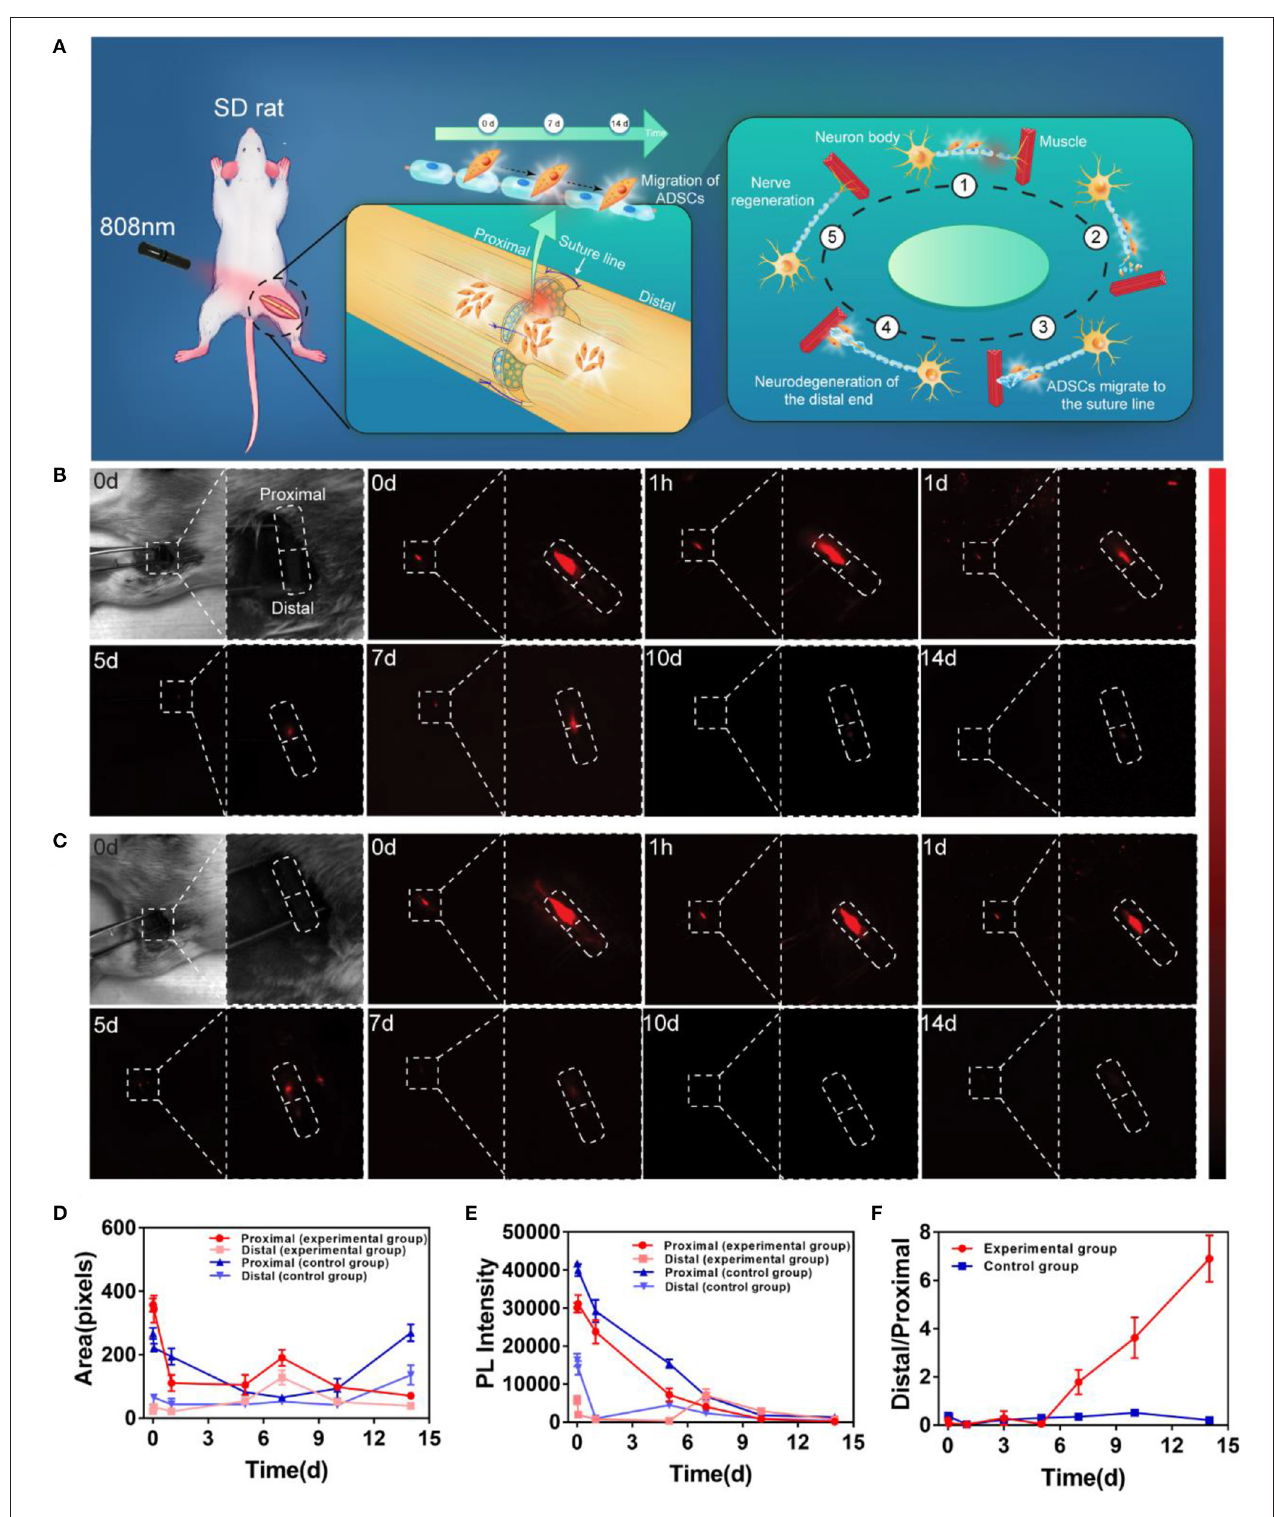
FIGURE 4 | In vivo distribution and migration of PbS QDs labeled ADSCs in a rat model of sciatic nerve injury. (A) Schematic illustration of the in vivo NIR-II imaging strategy. (B) Bright field photograph of the region of interest and NIR-II imaging of the experimental group (injected with PbS QDs labeled ADSCs) in a time course (0 d, 1h, 1 d, 5 d, 7 d, 10 d, and 14 d post-injection). (C) Bright field photograph of the region of interest and NIR-II imaging of the control group (injected with pure PbS QDs) in a time course (0 d, 1h, 1 d, 5 d, 7 d, 10 d, and 14 d post-injection). (D) Fluorescence area and (E) PL intensity of the proximal and distal sections of the sciatic nerve. (F) The ratio of PL intensity in distal/proximal nerve sections in the experimental group and the control group.